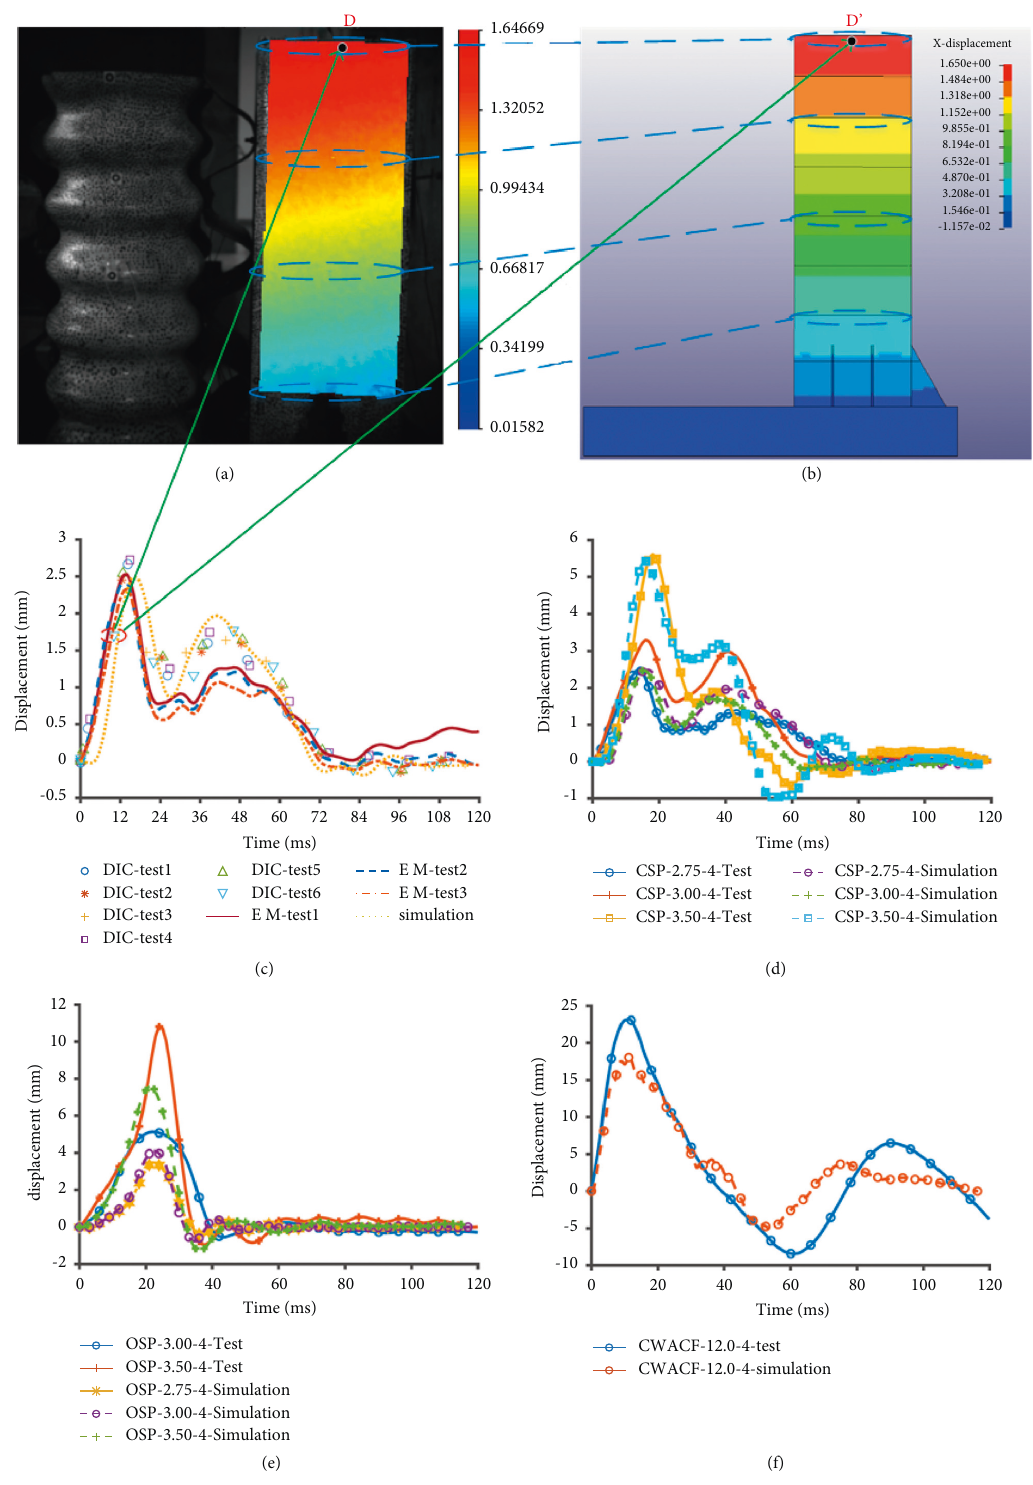
Figure 5: Comparison between experimental results and simulation results of lateral displacement field and lateral displacement time history curve of column (unit: mm). (a) The experimental result of CSP-2.75-4; (b) simulation result of CSP-2.75-4; (c) time history curve of CSP-2.75-4; (d) CSP; (e) OSP; (f)